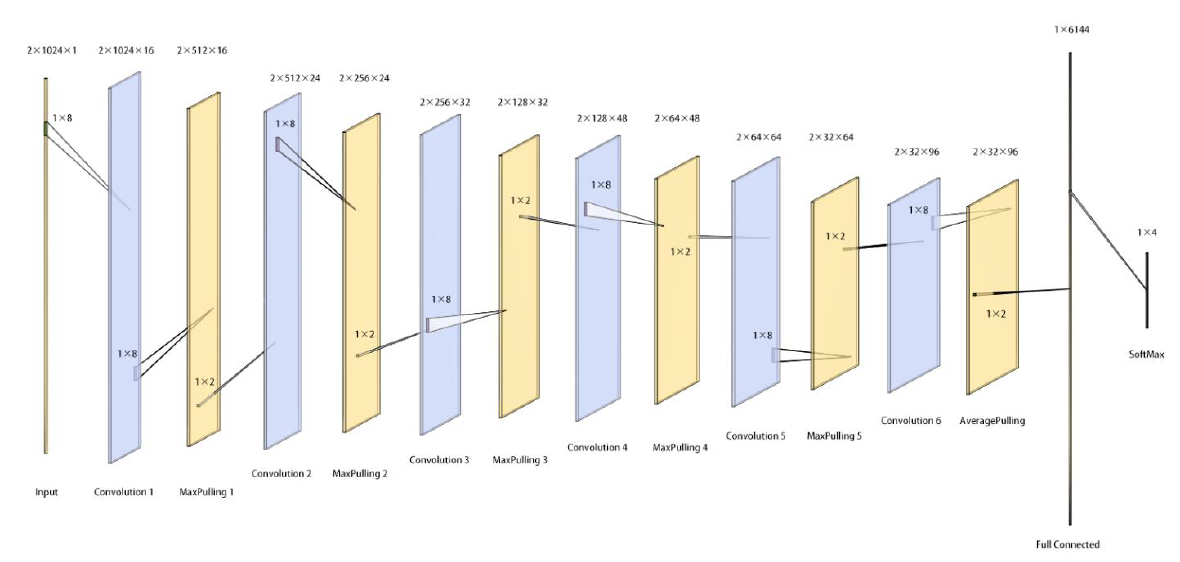
Figure 8. Simplified network structure with feature matrix size and stride size.